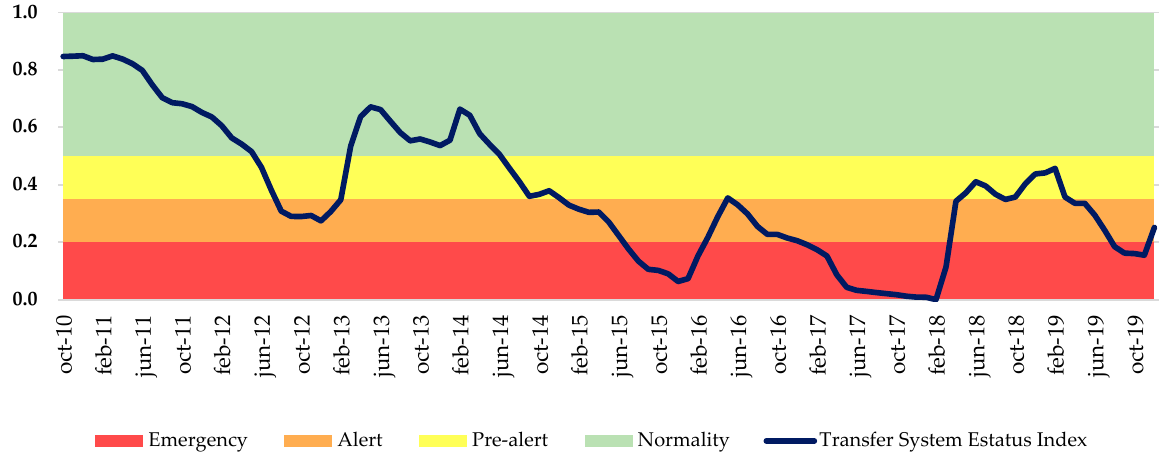
Figure 7. Evolution of the Transfer System Status Index, period October 2010-December 2019. Source: own elaboration based on [63].